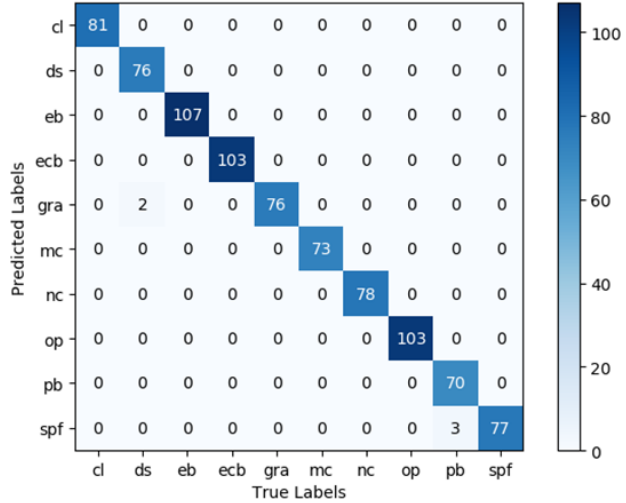
Figure 9. Confusion matrix.